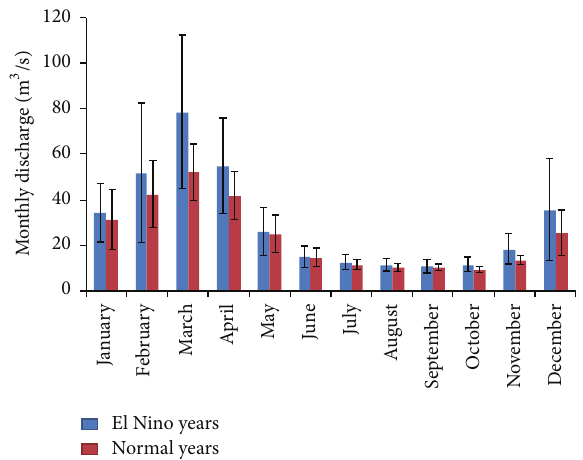
Figure5:MonthlymeandischargeduringElNinoyearsandnormal years at Chamriz